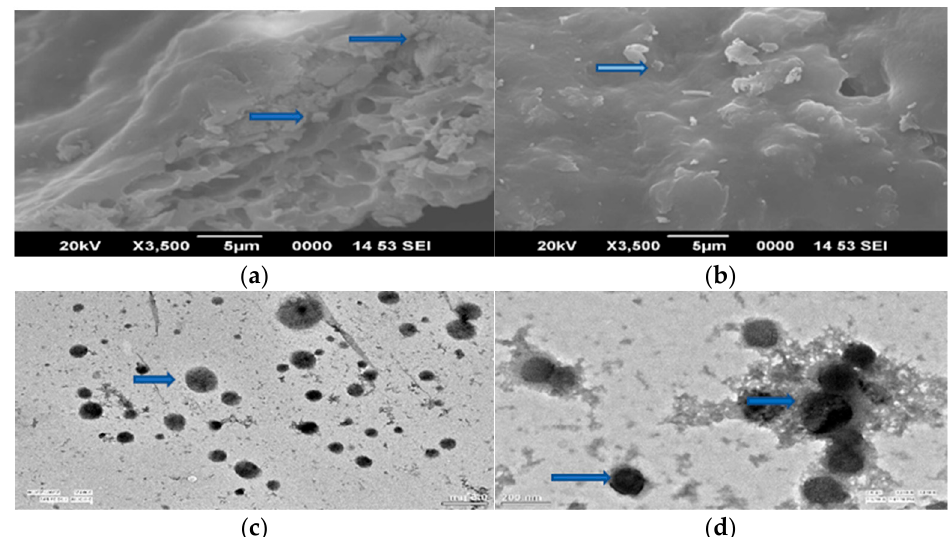
Figure 3. SEM and TEM micrographs of blank and mancozeb loaded NCs: SEM ( a ) blank CSGA NCs; ( b ) CSGA-M-1.0: NCs containing 1.0 mg/mL mancozeb; TEM: ( c ) Blank CSGA NCs; ( d ) NCs containing mancozeb i.e., CSGA-M-1.0.